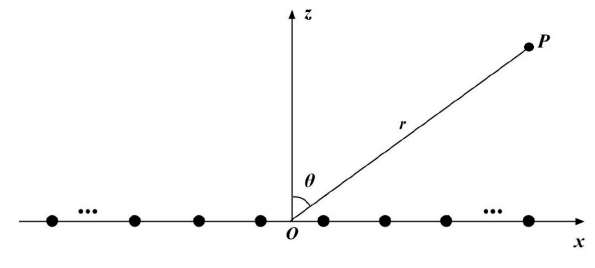
Figure 1. The geometry of the linear antenna array.